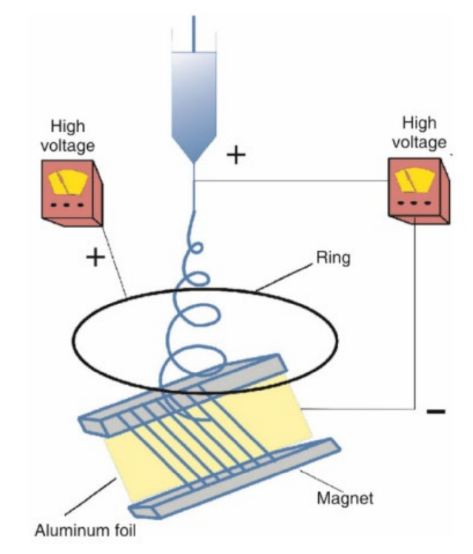
Figure 6. Schematic diagram of magnetic field electrospinning